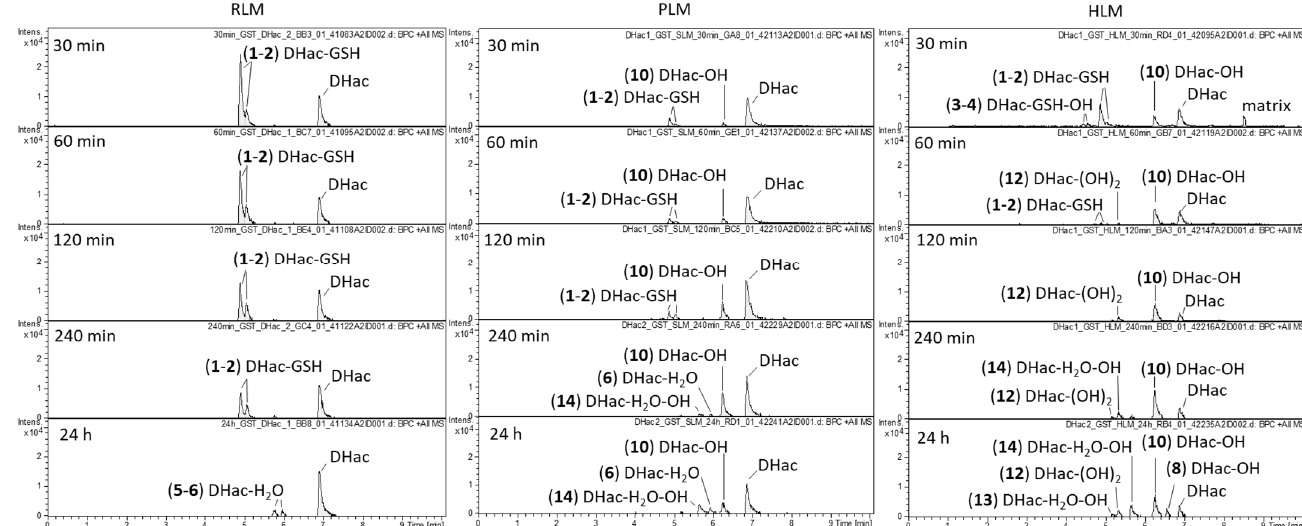
Figure 2. Difference chromatograms of DHac after incubation with RLM, PLM or HLM, NADPH regenerating system, GST and GSH for 30 min, 60 min, 120 min, 240 min and 24 h, respectively.